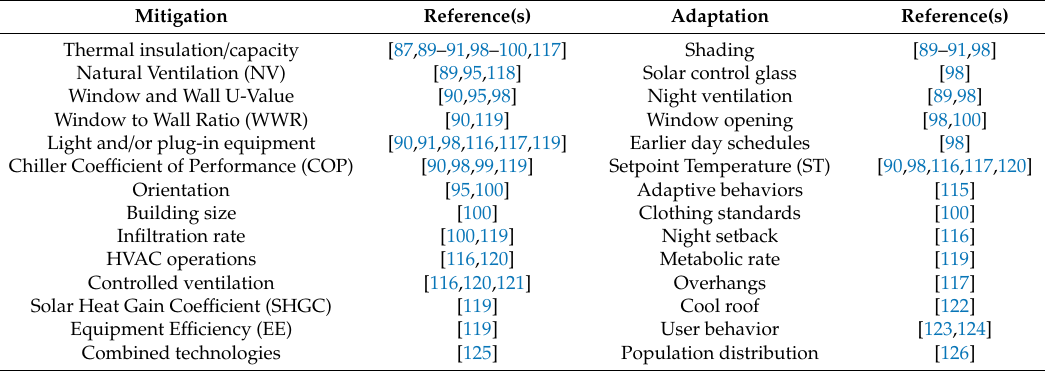
Table 4. Summary of adaptation and mitigation responses to the changing